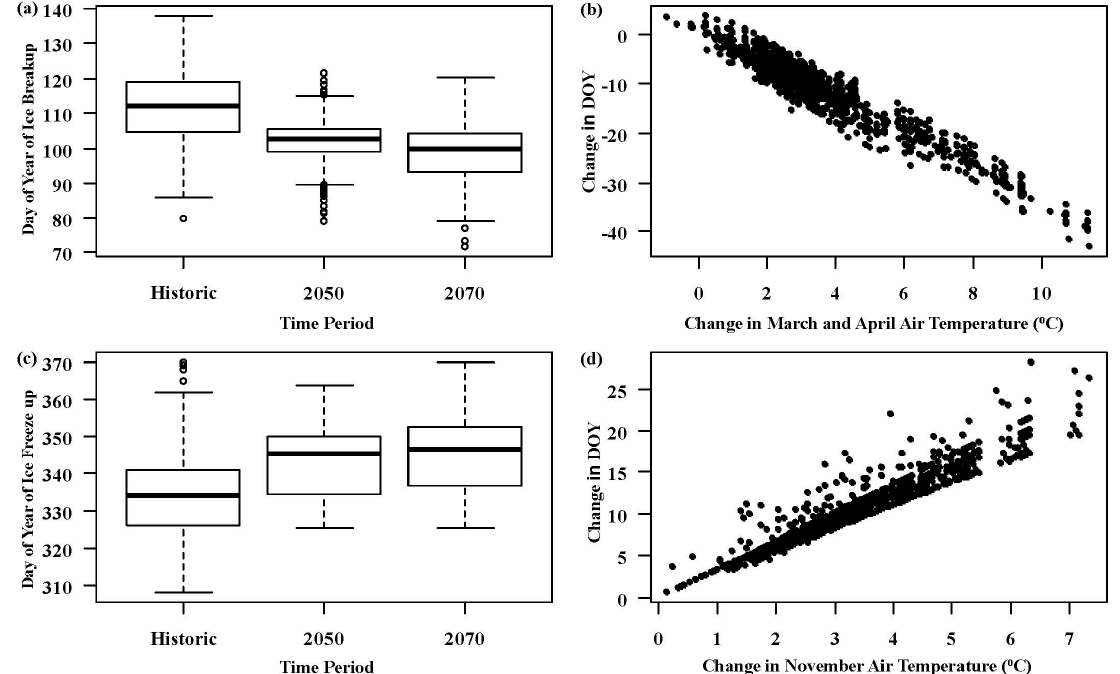
Figure 4. ( a ) The timing of lake ice breakup (day of year) for the historic period (1981/2–2014/5), and forecasted in 2050, and 2070; ( b ) Forecasted change in the day of ice breakup with the corresponding change in mean March–April air temperature under 126 projected climate scenarios; ( c ) The timing of lake ice freeze up (day of year) for the historic period (1981–2015), 2050, and 2070; ( d ) Forecasted change in the day of ice freeze up with the corresponding change in mean November air temperature under 126 projected climate scenarios.